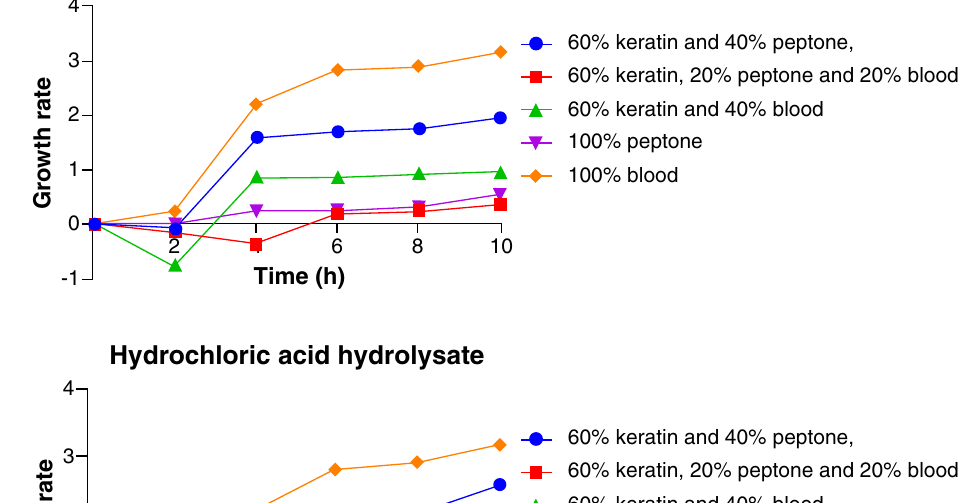
SO and HNO 2 4 3